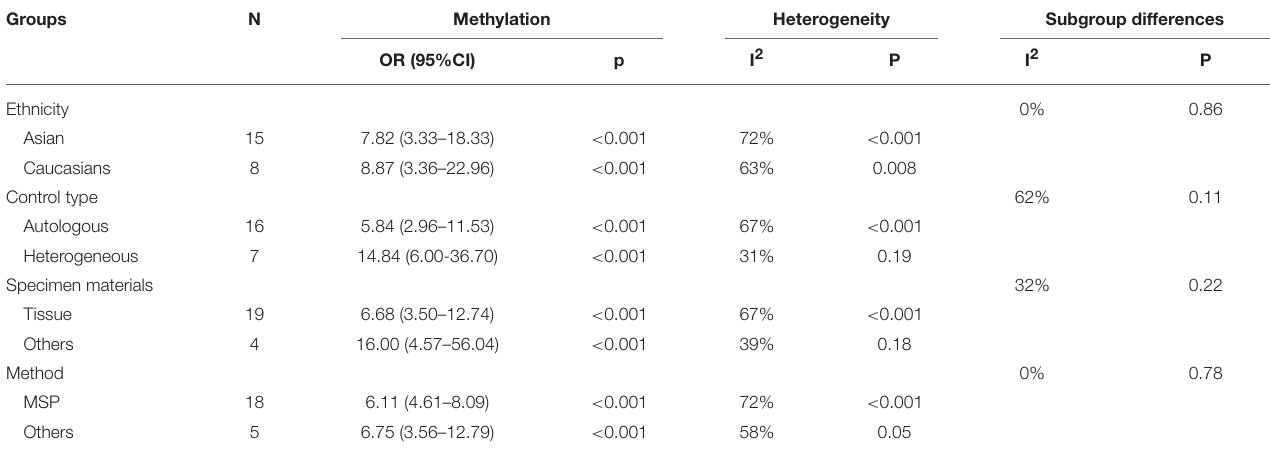
TABLE 2 | Stratified analysis of the association between hMLH1 methylation and gastric cancer risk. Groups